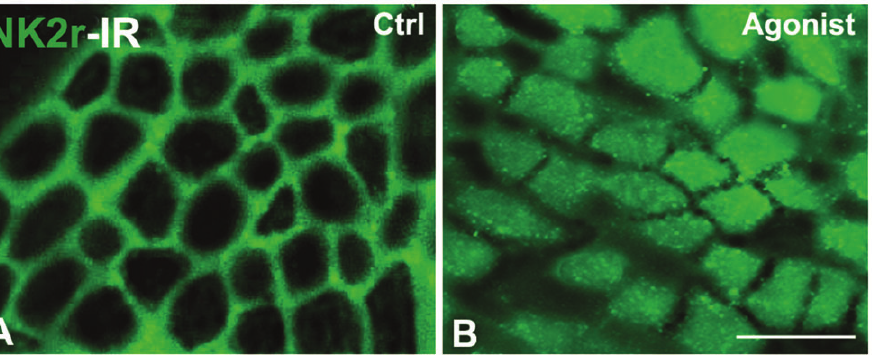
Figure 2 Human colon. NK2r labeling under a confocal microscope. IR appears as small brilliant green granules. (A) Cells with a non-internalized NK2r. IR is distrib- uted along the cell contour. (B) Cells with internalized NK2r particles. The specimen was treated with 1 μ m of the NK2r agonist [ β Ala 8 ]NKA (4 – 10). The IR granules are deeply located within the cytoplasm. In some cells, the nucleus is completely masked. Calibration bar, 10 μ m (Vannucchi and Evangelista, Unpublished data).